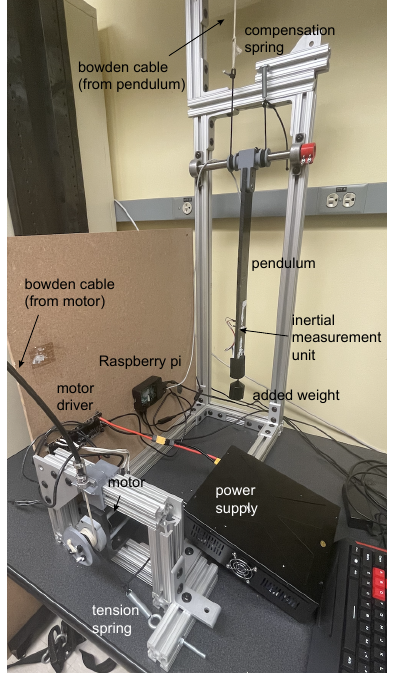
Figure 6. Hardware setup to verify the event-based adaptive